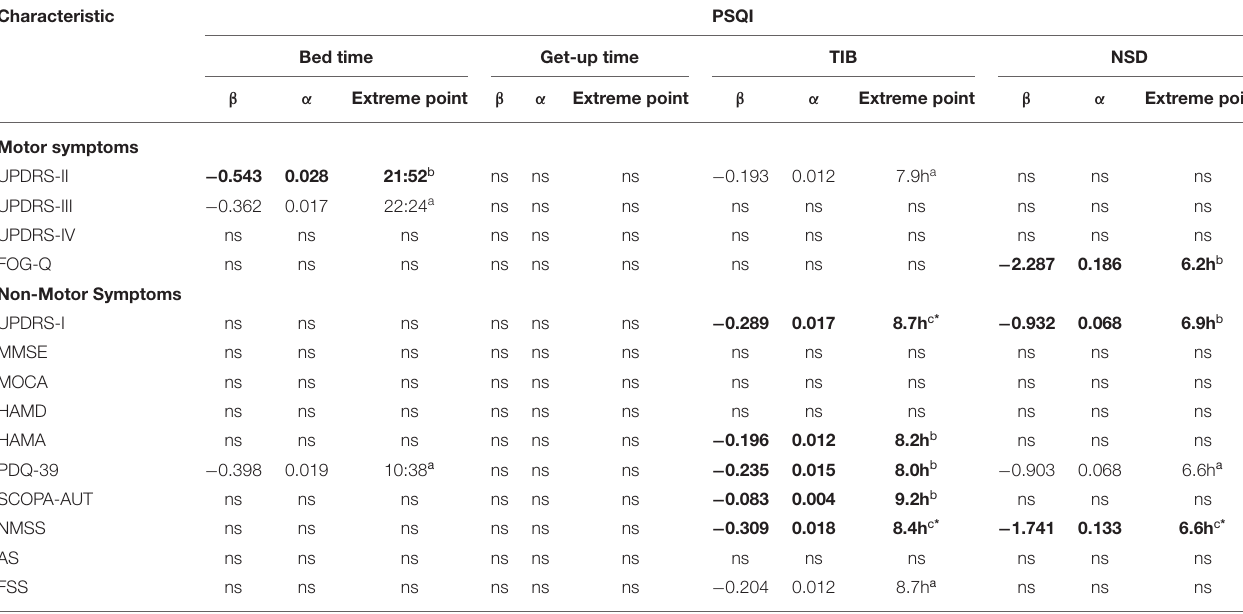
TABLE 2 | The associations of PSQI parameters with PD characteristics using nonlinear regression models. Characteristic